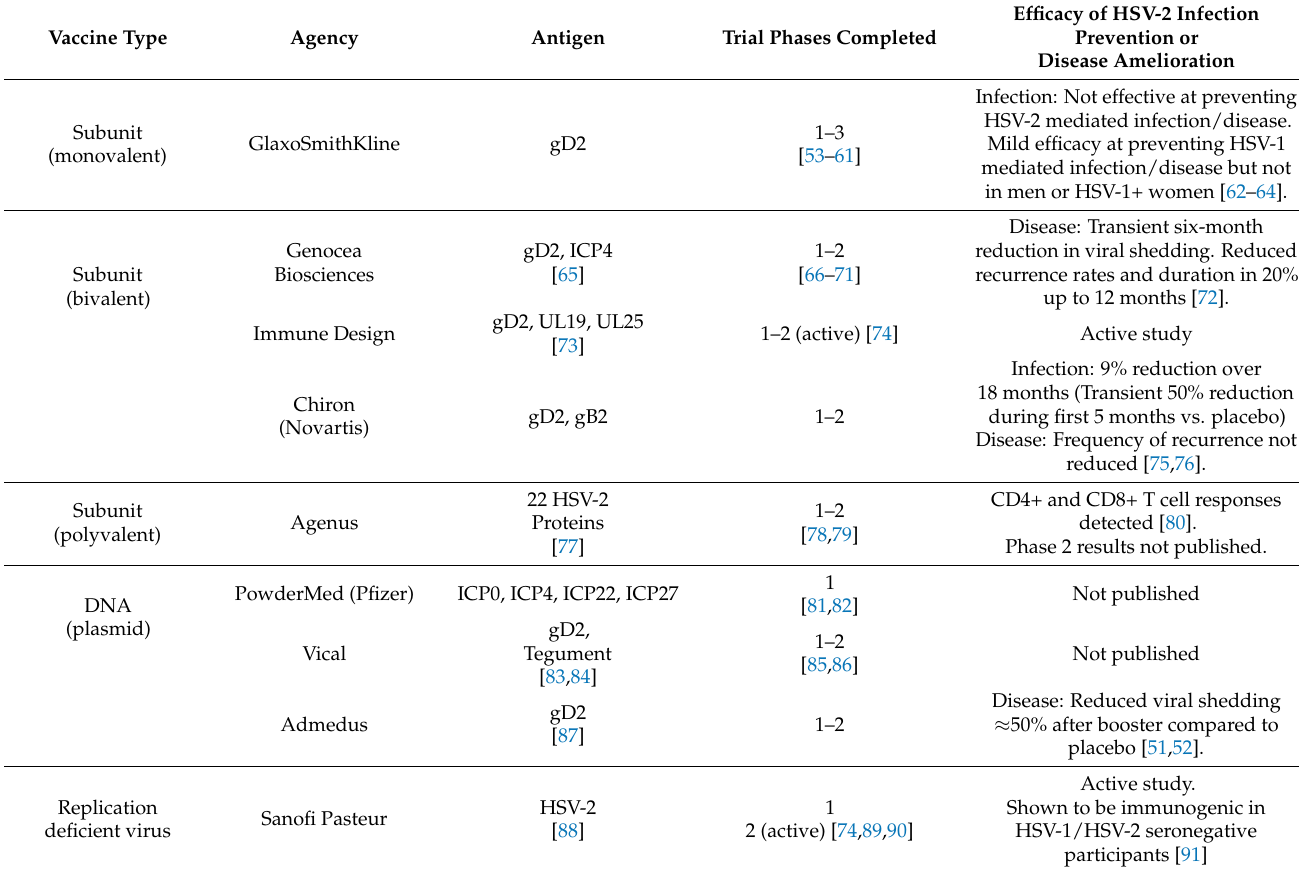
Table 1. A brief review of HSV-2 vaccine candidates having completed various clinical trial phases from 1990–2020. Clinical trials include those registered with clinicaltrials.gov as well as relevant unregistered trials from academic universities and agencies outside the United States who collaborated with US institutions. gD2: glycoprotein D, gB2: glycoprotein B, ICP: infected cell protein, UL: unique